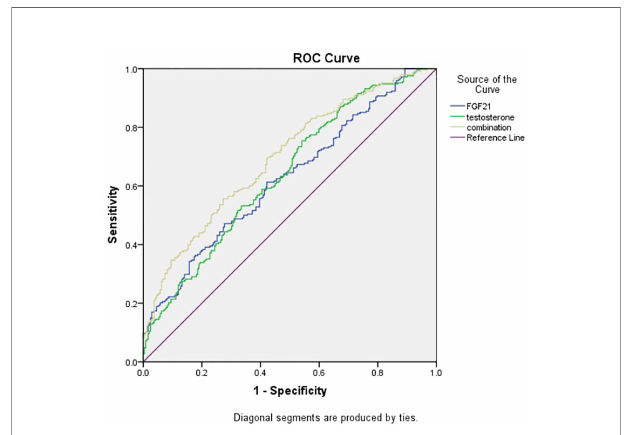
FIGURE 3 | ROC curve of serum FGF21 and testosterone in predicting the occurrence of CAD in T2DM